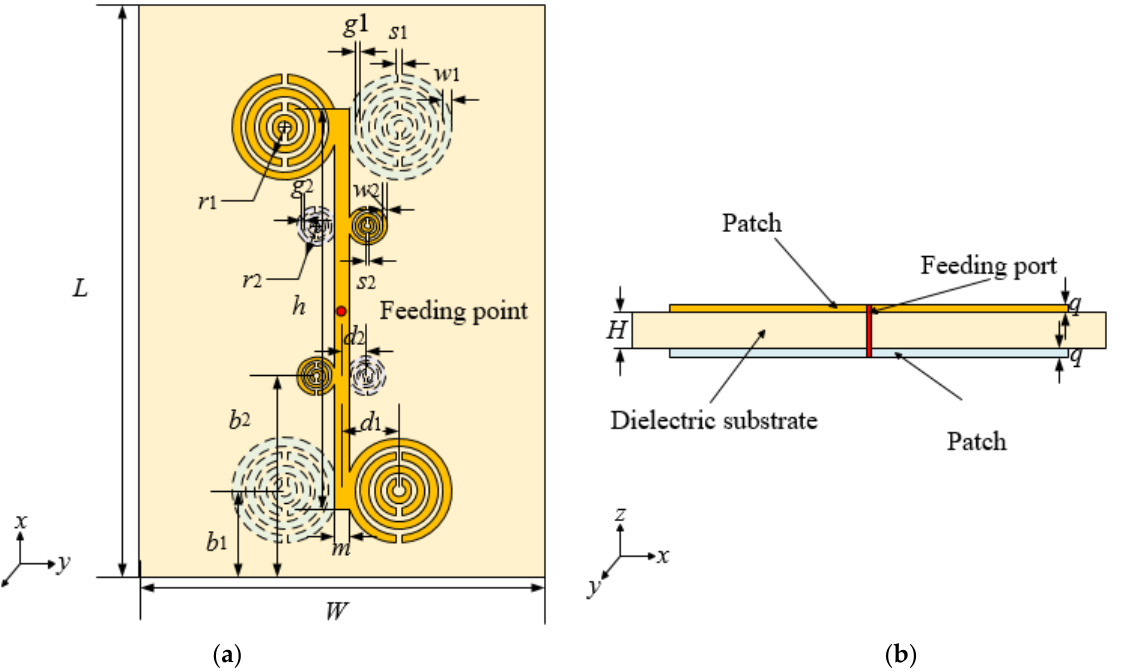
Figure 10. Proposed dual-band antenna with ( a ) the top view; ( b ) the side view.